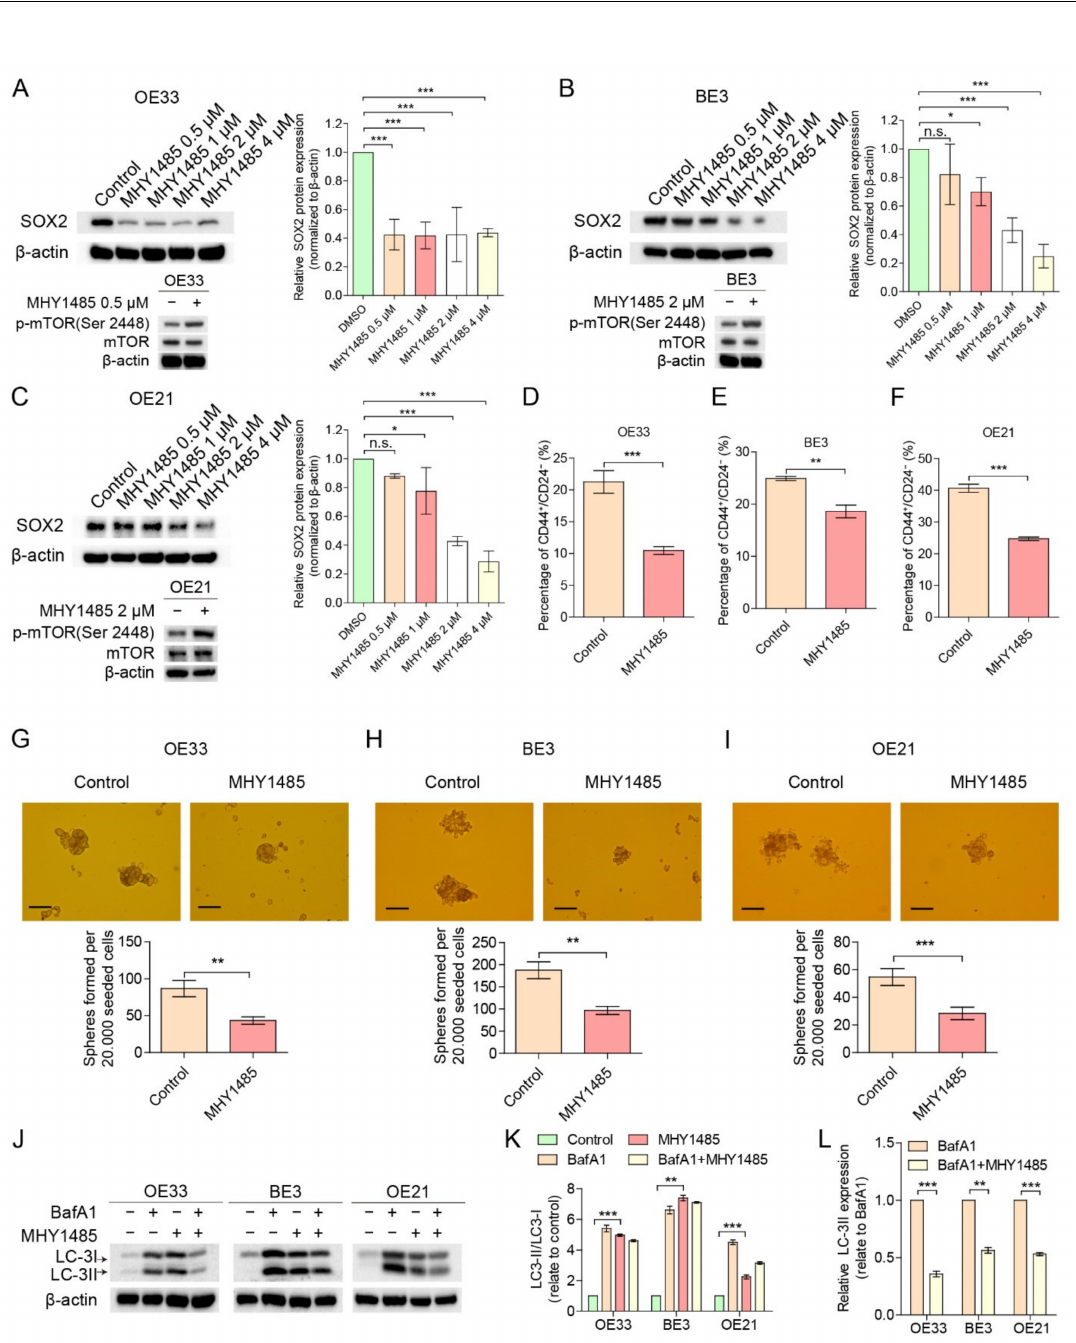
Figure 3. mTOR inducer MHY1485 down-regulates CD44 + /CD24 − CSC population, sphere forma- tion and autophagy. ( A – C ) Cells treated with MHY1485 showed a decreased expression of SOX2 compared to DMSO controls (OE33 ≥ 0.5 µ M, BE3 ≥ 1 µ M and OE21 ≥ 2 µ M). ( D – F ) Cells treated with MHY1485 (OE33 at 0.5 µ M, BE3 at 1 µ M and OE21 at 2 µ M) for 48 h showed a down-regulation of the CD44 + /CD24 − CSC population compared to DMSO controls ( n = 3). ( G – I ) Cells treated with MHY1485 (OE33 at 0.5 µ M, BE3 at 1 µ M and OE21 at 2 µ M) for 48 h had a decreased sphere generation capacity compared to DMSO controls ( n = 3). Scale bar = 100 µ m. ( J – L ) Western blots analysis of LC-3II/LC-3I in cells treated with MHY1485 (OE33 at 0.5 µ M, BE3 at 1 µ M and OE21 at 2 µ M) or control for 48 h followed by either 10 µ M bafilomycin A1 or DMSO for an additional 4 h. Error bars indicate SD. n.s., not statistically significant; * p < 0.05, ** p < 0.01 and *** p < 0.001